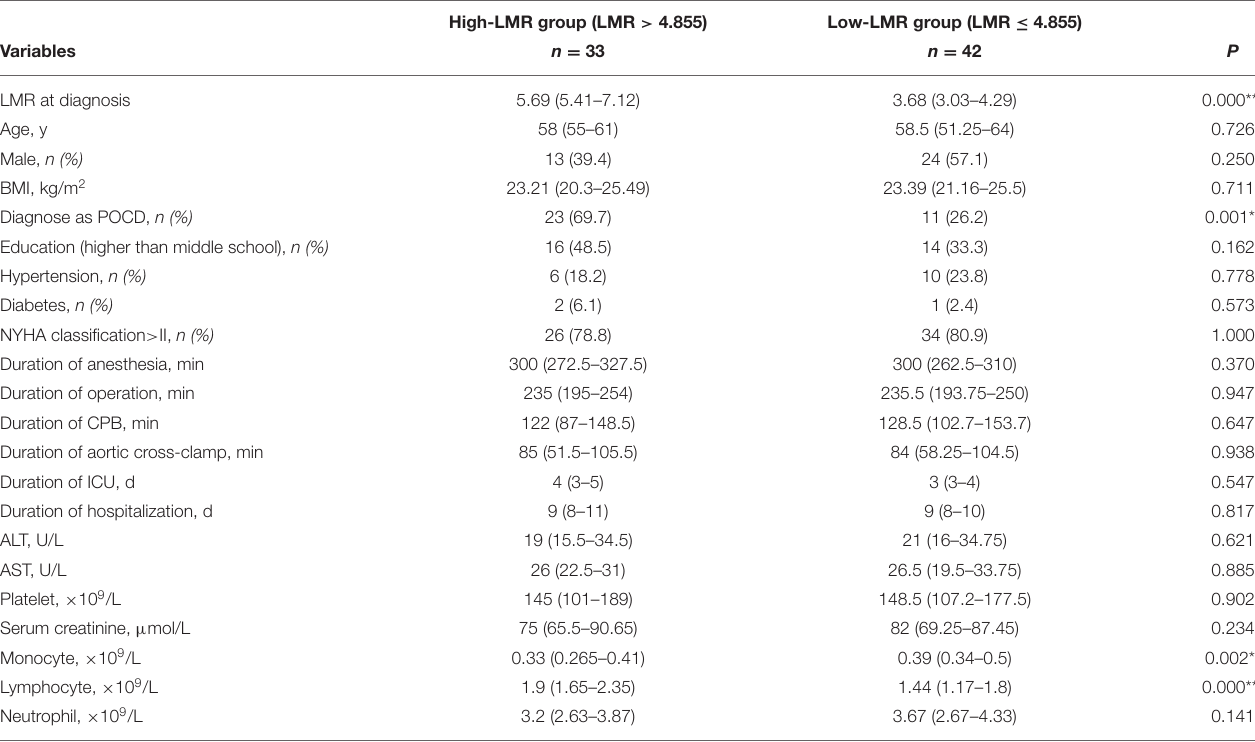
TABLE 4 | Clinical features of High-LMR group and Low-LMR